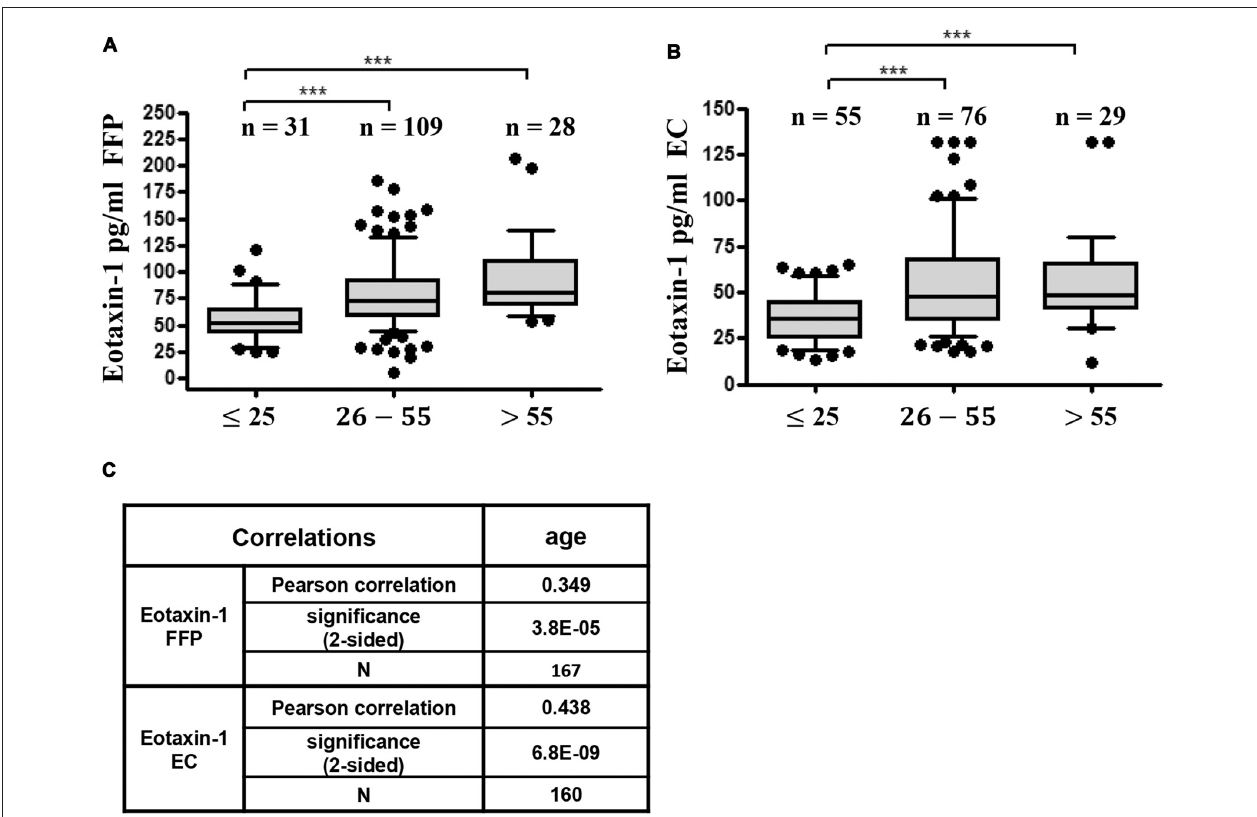
FIGURE 3 | Eotaxin-1 correlates with age. (A,B) Eotaxin-1 was measured in (A) FFP and (B) EC and analyzed in dependence of age. Data are presented as Box-Whiskers Plot, showing median and 10–90 percentiles. Statistical analysis was performed using Kruskal-Wallis one way ANOVA test including Dunn’s post hoc analysis ( ∗∗∗ p < 0.001). (C) Pearson correlation analysis of eotaxin-1 in FFP and EC with